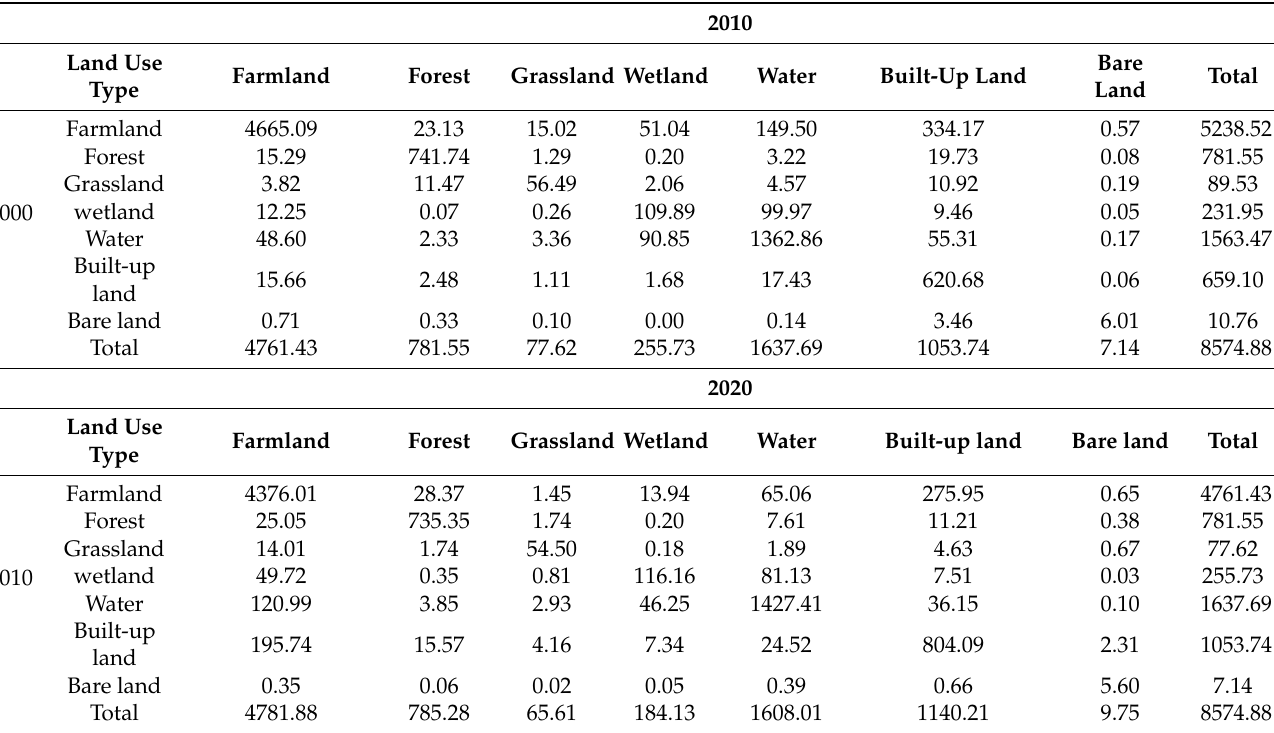
Table 4. Land use transition matrix during 2000–2020 in Wuhan (km 2 ).